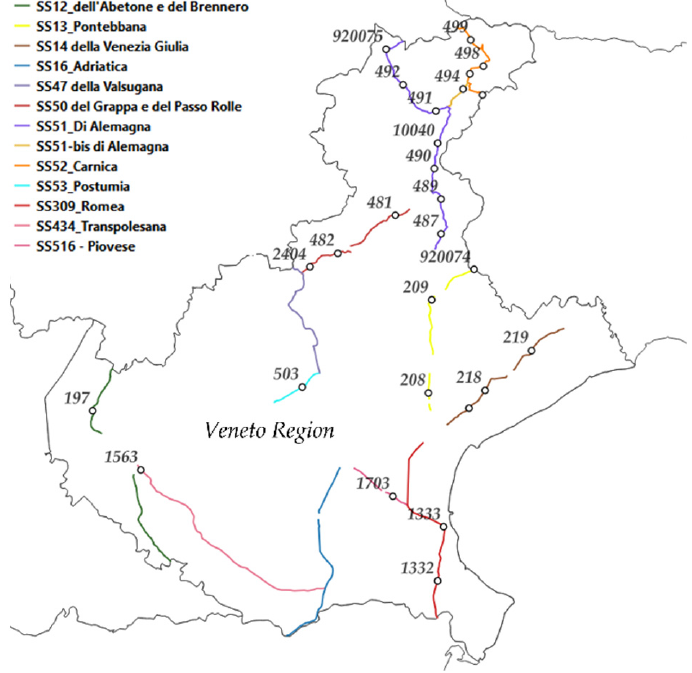
Figure 1. Location of the measuring sections along the state roads of the Veneto Region, reported in the legend.